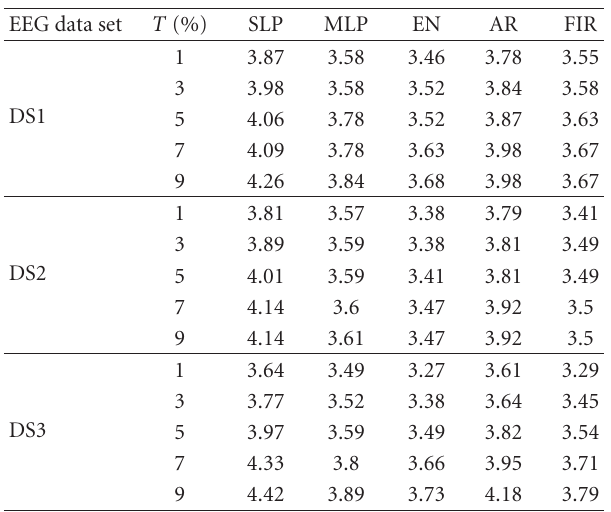
Table 3: Values of CR obtained at Q1.